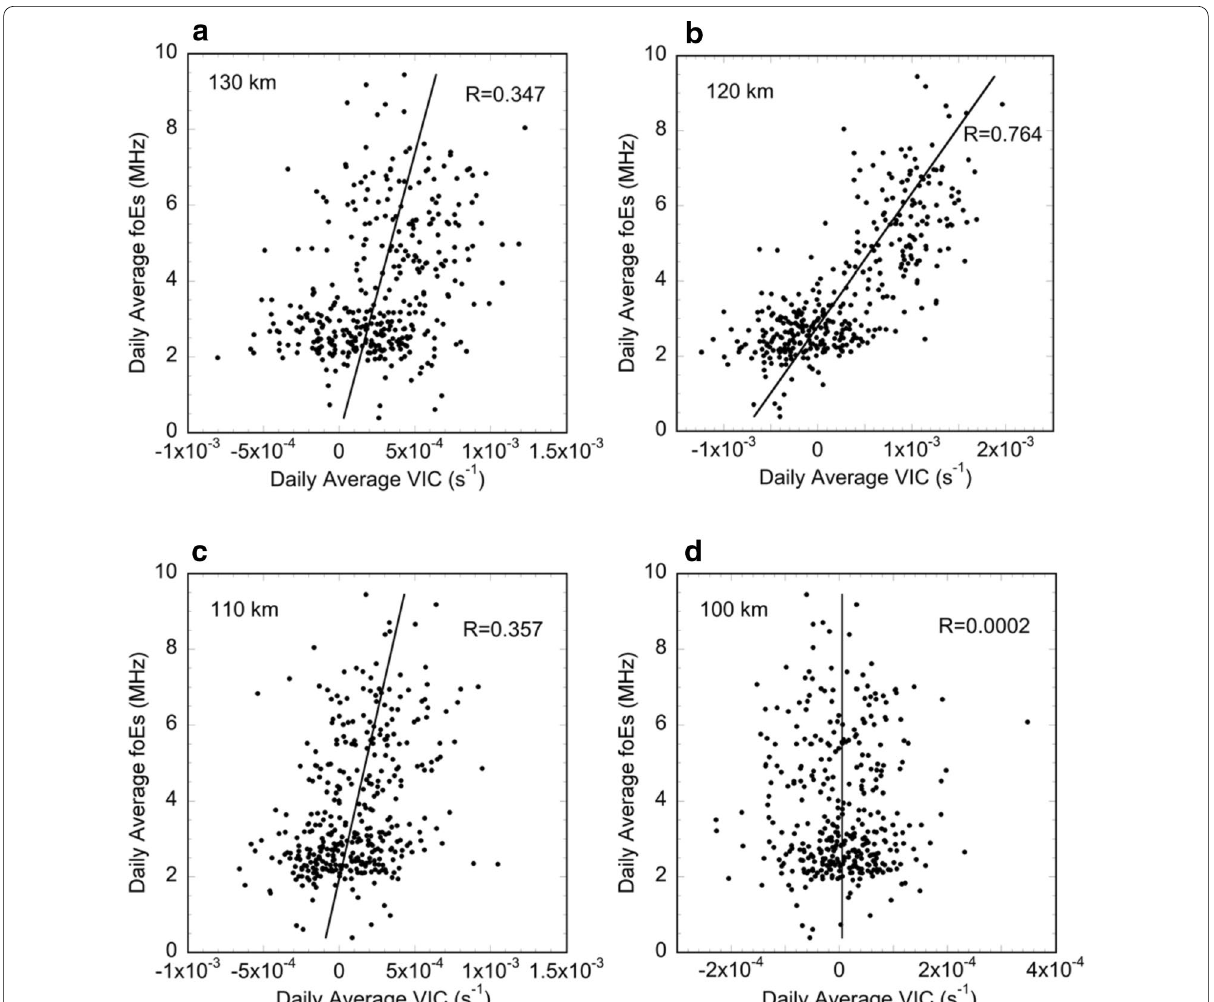
Fig. 3 Correlations of daily average foEs and VIC . Scatter plots and correlation coefficients of the daily average foEs and VIC are shown at four different altitudes at Kokubunji in 2009